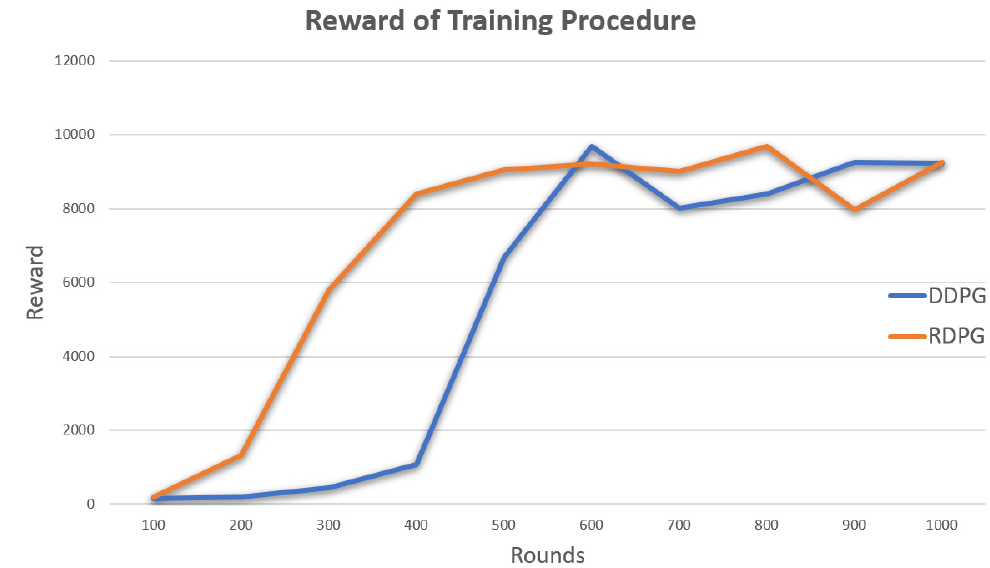
Figure 12. The reward comparison between the DDPG and RDPG in the training procedure.